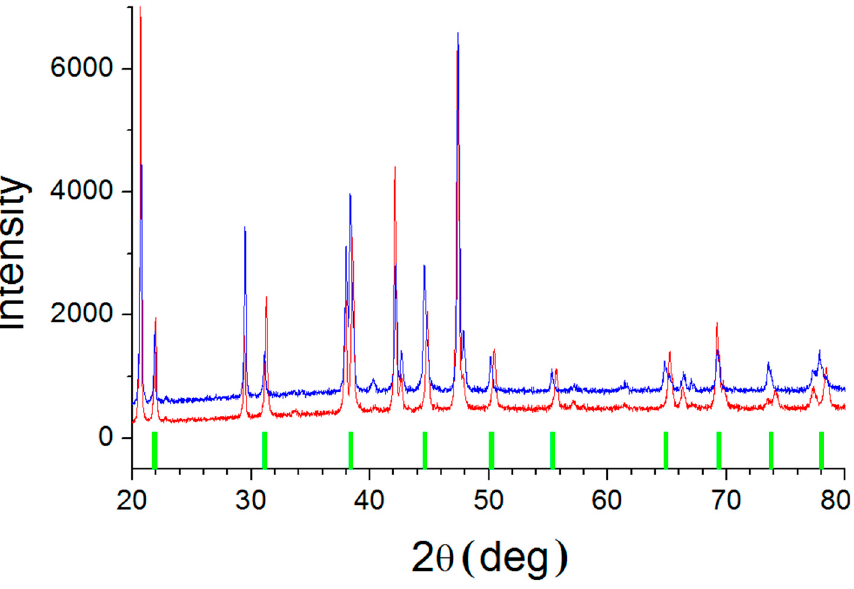
Figure 7. XRD pattern for the alloys: Al–36.28Cu–9.02Zr (Z3—blue curve), Al–35.66Cu–15.36Hf (H5—red curve), green markers indicate the aluminide phase with a cubic L1 2 lattice.